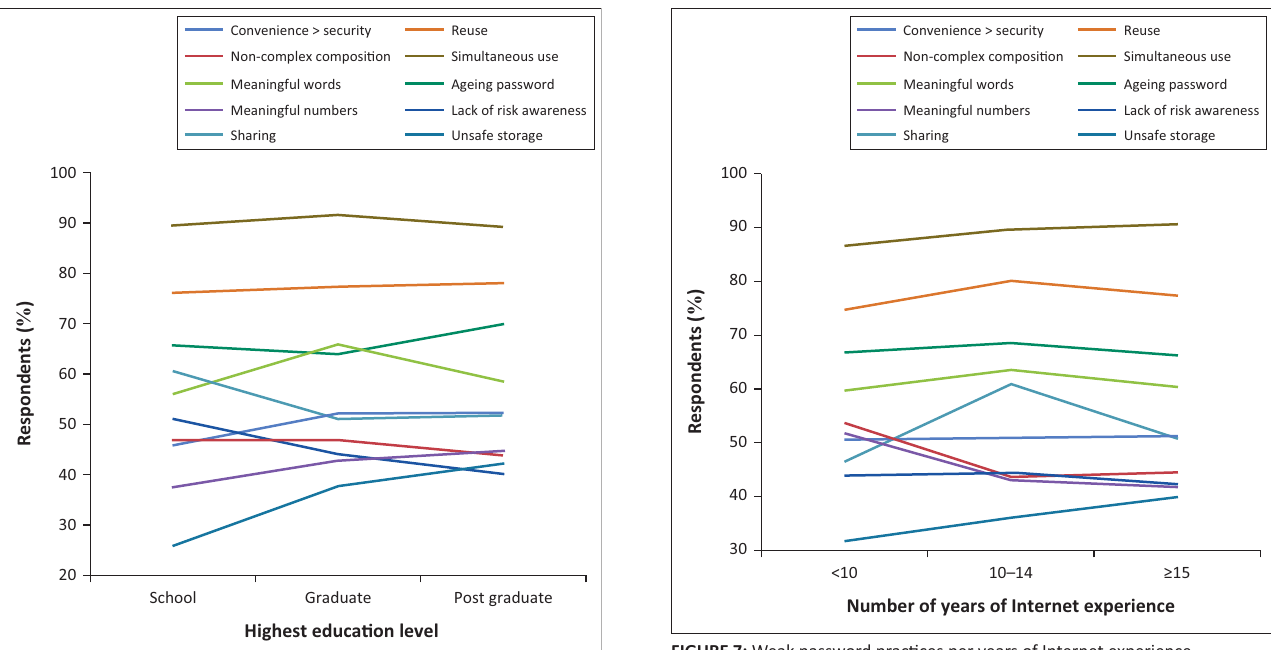
FIGURE 7: Weak password practices per years of Internet